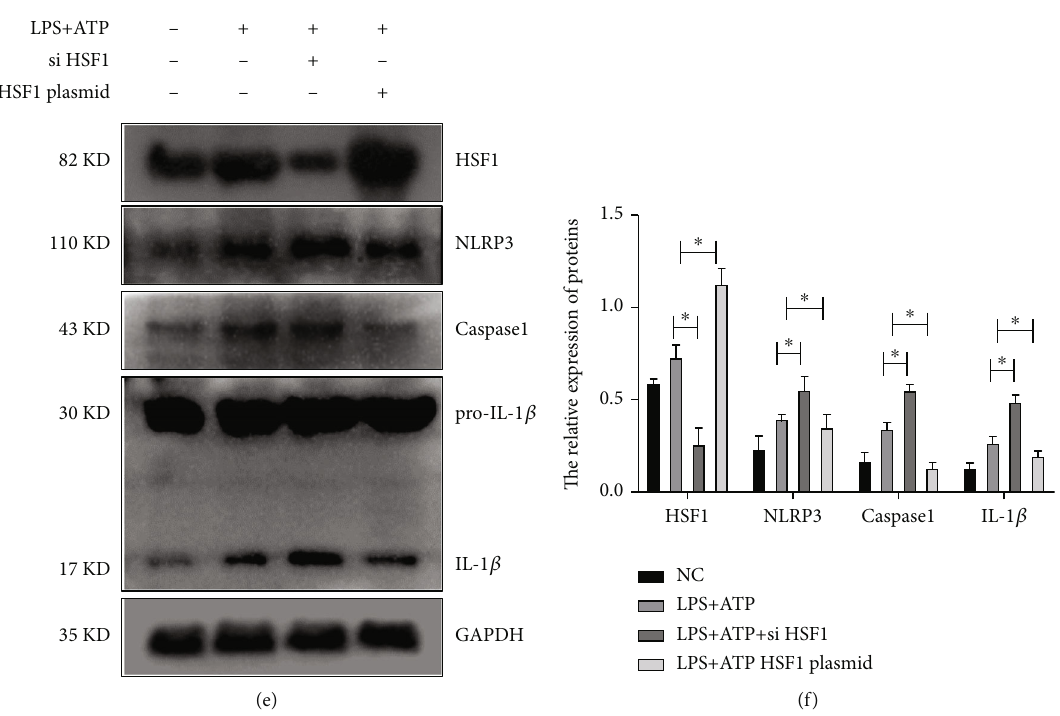
Figure 7: HSF1 can inhibit pyroptosis through NLRP3. (a, c) Western blot was used to detect the expression of the in fl ammatory cytokines and pyrolytic proteins in PC12 cells, ∗ p < 0 : 05 . (b, d) EthD-III staining (red) was labeled as pyroptosis, and Hoechst staining (blue) was tagged as nuclei. NC: negative control group; si H: hsf1 silence group; si H+N: hsf1 and nlrp3 silence group. Experiments were repeated independently, ∗ p < 0 : 05 . (e, f) Western blot was used to detect the expression of the in fl ammatory cytokines and pyrolytic proteins in PC12 cells. NC: negative control group; LPS+ATP: LPS+ATP-treated group; LPS+ATP+si HSF1: LPS+ATP-treated PC12 cells transfected with HSF1 siRNA; LPS+ATP+HSF1 plasmid: LPS+ATP-treated PC12 cells transfected with HSF1 plasmid, ∗ p < 0 : 05 . Scale bar: 100 μ m, apply to all the